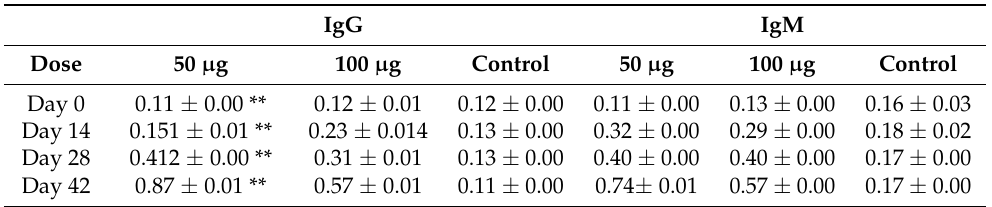
Table 4. Antibody responses before and after the second booster dose of VT1 antigen in immunized and control rabbits.